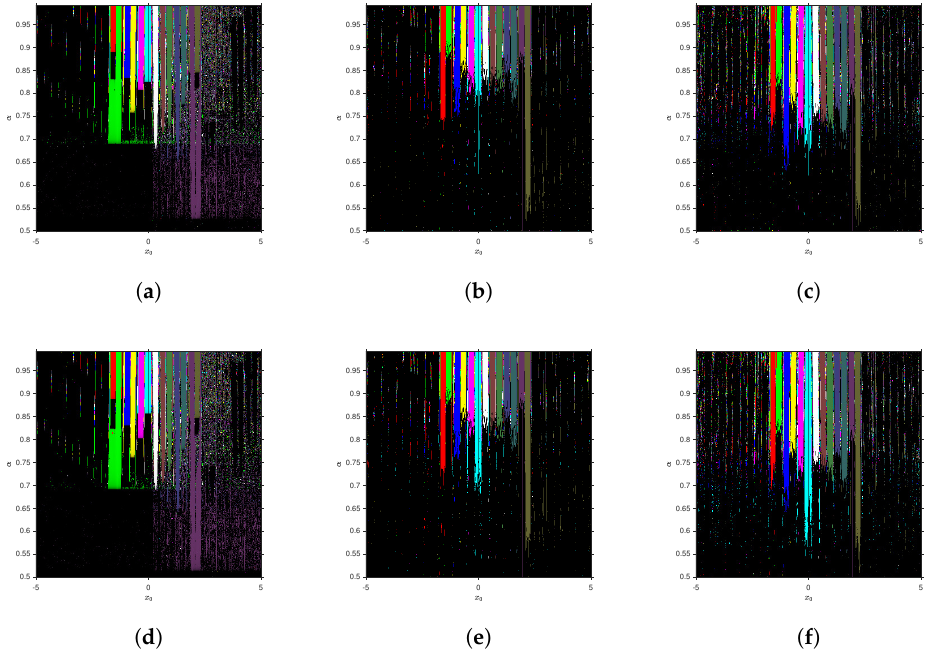
Figure 4. Convergence planes of fractional Newton and Traub-type methods on f 3 ( x ) with − 5 ≤ x 0 ≤ 5. ( a ) CFN 1 , 30.39% convergence; ( b ) CFN 2 , 16.46% convergence; ( c ) CFT, 24.29% convergence; ( d ) R-LFN 1 , 30.06% convergence; ( e ) R-LFN 2 , 16.88% convergence; ( f ) R-LFT, 25.04%